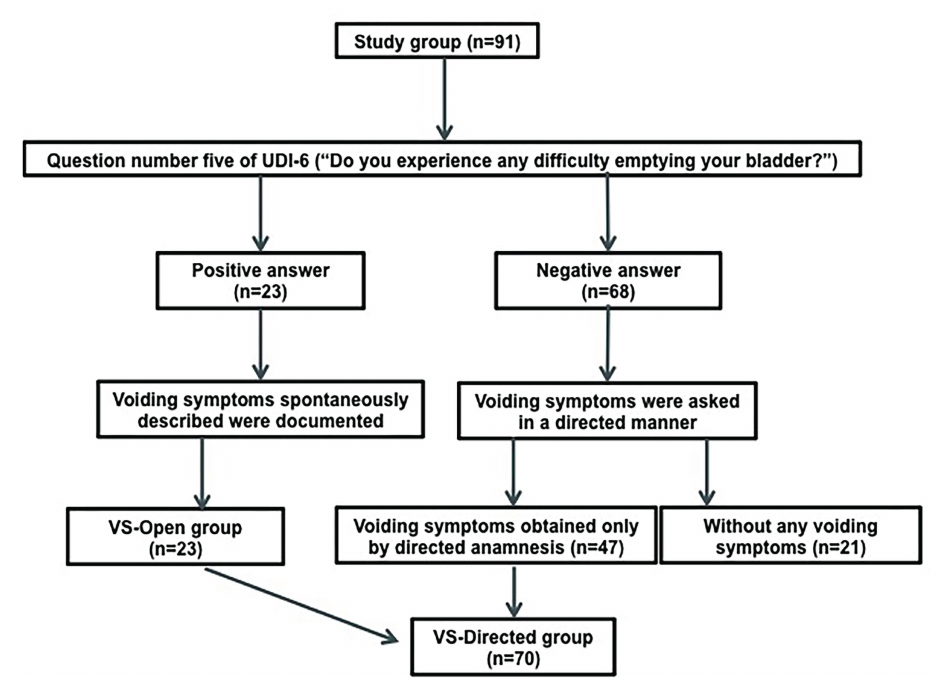
Figure 2 - Flowchart of the standardized clinical history procedure performed before every urodynamic study (UDI-6: Urogenital Distress Inventory Short Form